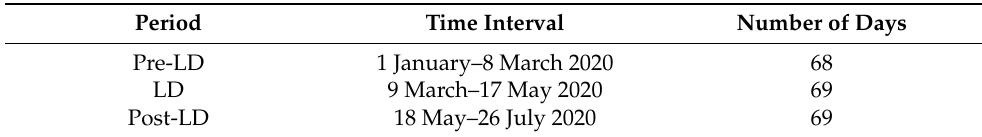
Table 1. Corresponding time intervals and number of days for the three selected periods Pre-LD, LD (lockdown), and